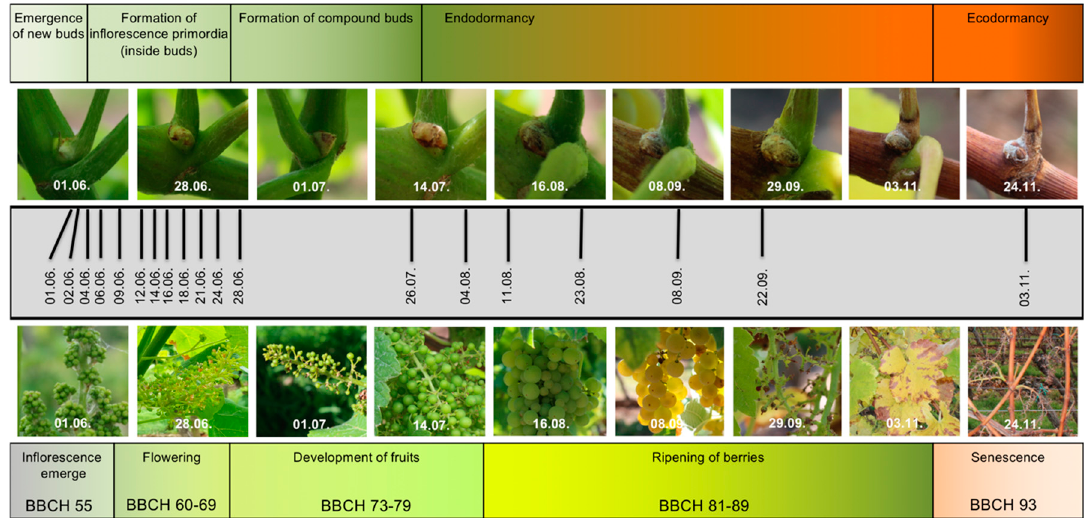
Figure 1. Documentation of the grapevine material used for sampling. The upper row of pictures displays the bud stages during the first year of development, which was the target of this study. The lower row of pictures displays the growth status of the vines from which the young buds were taken. Pictures were taken in parallel to harvest. In the center (grey bar), the sampling timeline is depicted. Above and below the pictures, the main developmental phases are mentioned, with the BBCH stages (see Methods) at the bottom for the second year of the two-year reproductive cycle of grapevine. The expression pattern of the MADS-Box genes VviAP1 (CRIBI2.1 ID